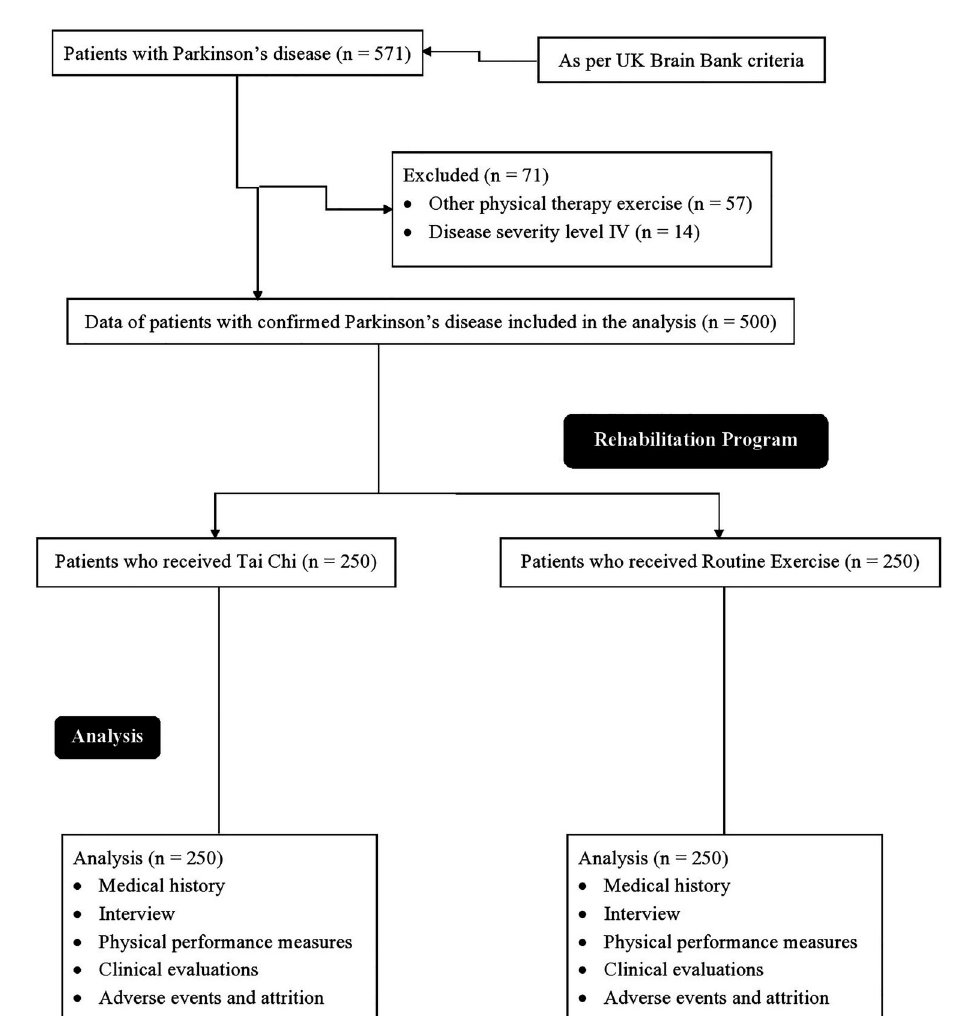
Figure 1. Flow diagram of the